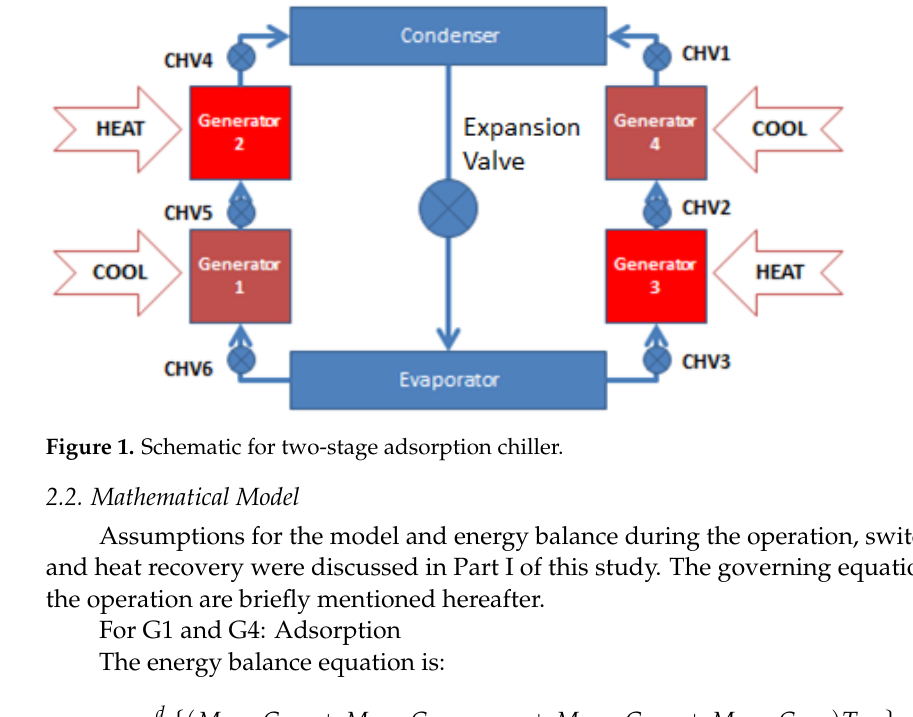
Table 1. Operation modes for the two-stage chiller with mass and heat recovery.